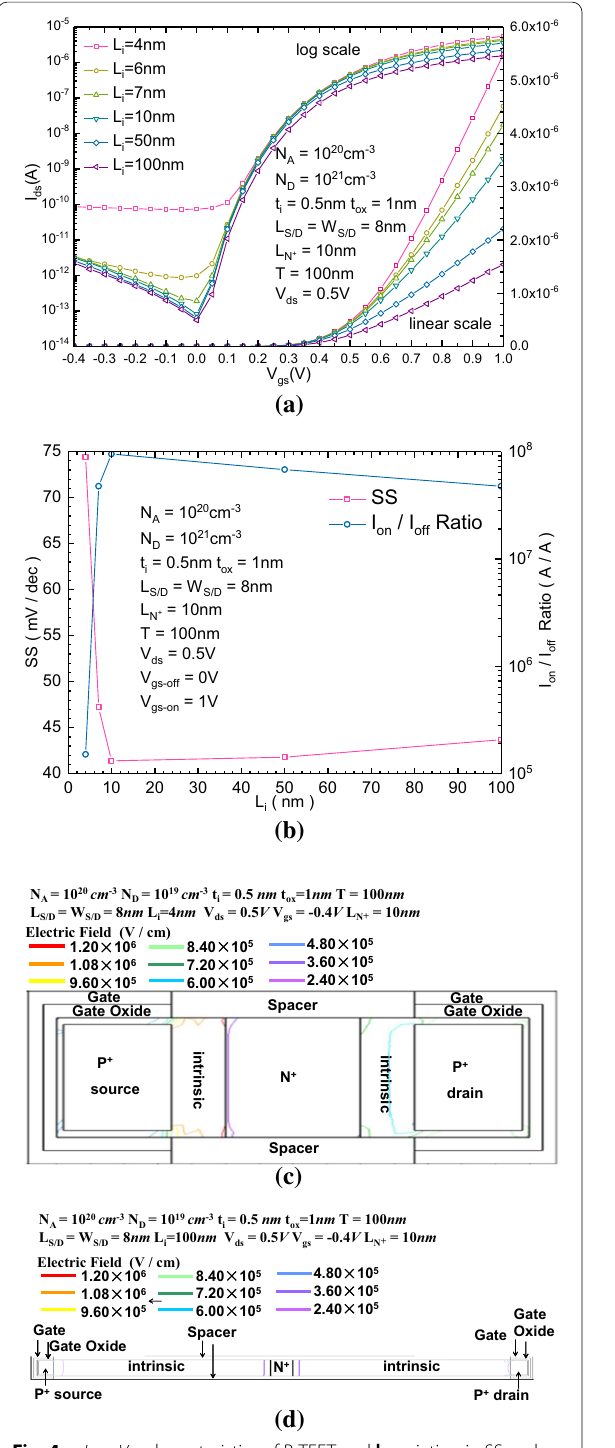
Fig. 4 a I ds − V gs characteristics of B‑TFET and b variation in SS and the I on − I off ratio with different L i ; 2‑dimensional reversely biased potential distribution of the proposed B‑TFET for L i equal to c 20 nm and d 100 nm